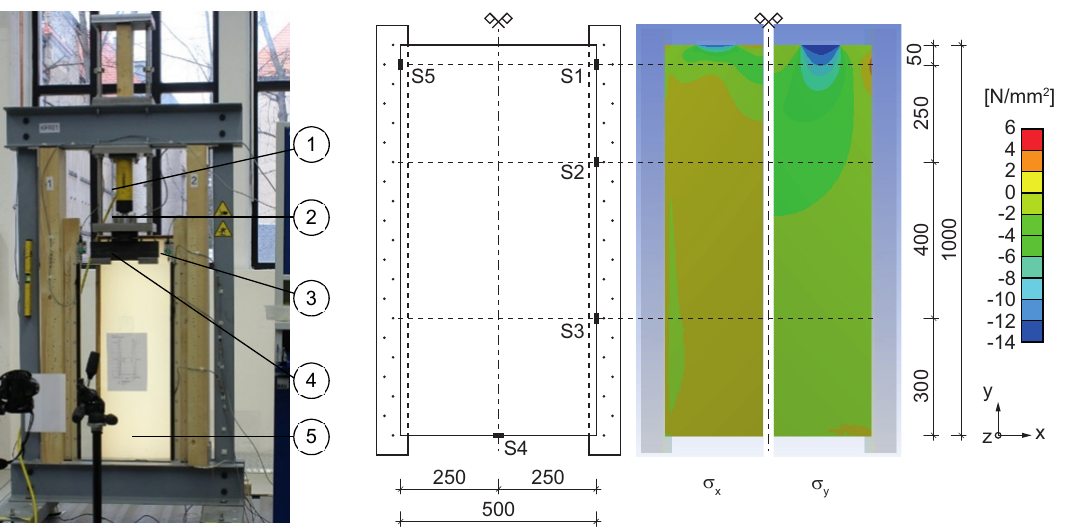
Fig. 4 Timber-glass specimen (5) mounted on the test Fig. 5 Strain gauge positions (DMS) and stresses derived from a finite element rig with hydraulik jack (1), load cell (2), displacement analysis using a linear elastic material model for the joint (adhesive C – transducer (3), load transfer to glass edge (4)